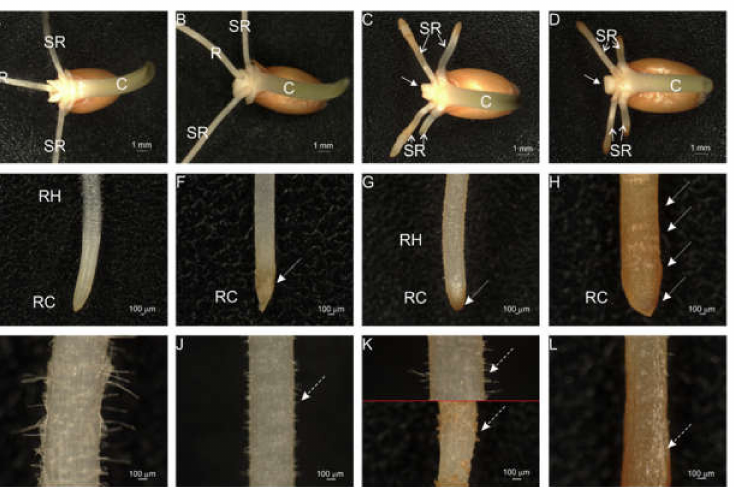
Figure 2. The morphology of 3-days-old seedlings of wheat ( Triticum aestivum L., cv. ‘Ostka Strz- elecka’) developing in the water ( A , E , I ) or (Bio)Ag NPs at 10 ( B , F , J ), 20 ( C , G , K ) or 40 mg/L ( D , H , L